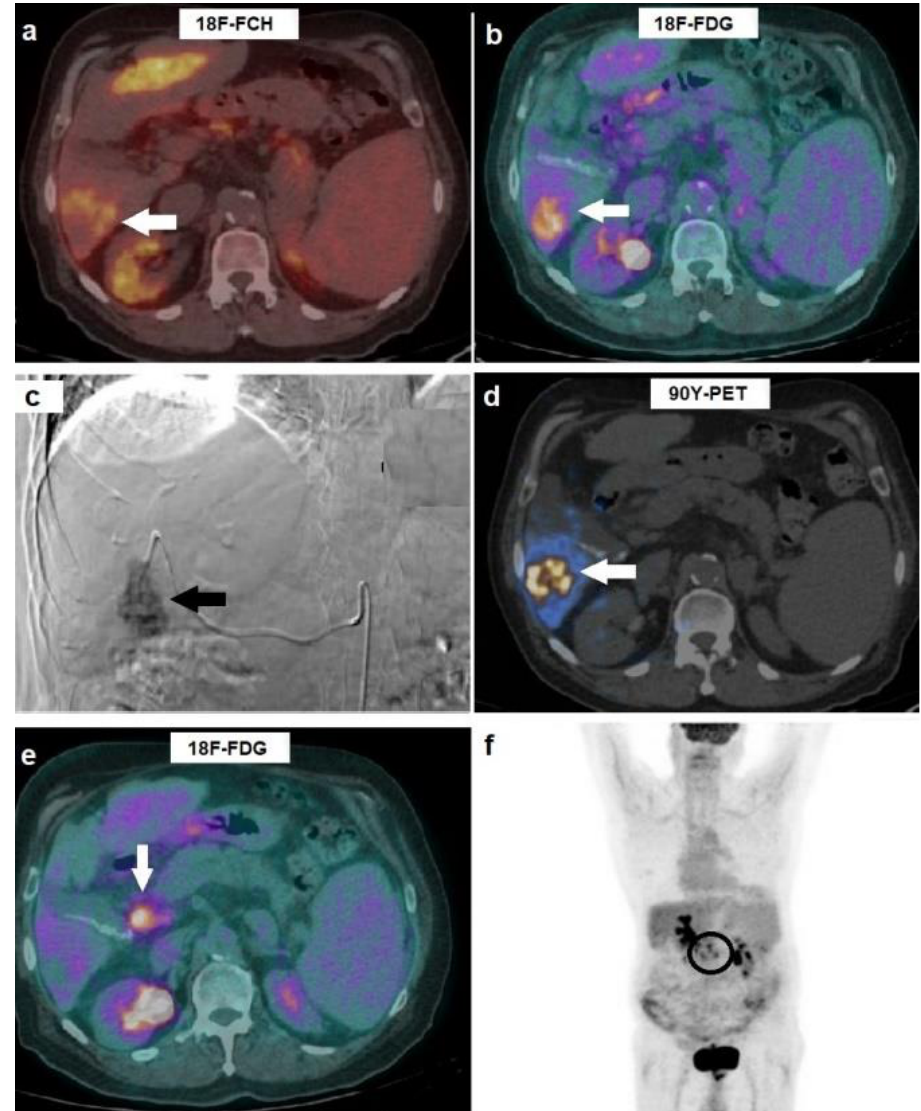
Figure 2. A 79-year-old man affected by HCV-related cirrhosis and HCC in the right hepatic lobe, previously treated with TACE and relapsed, referred to our center for 90 Y-TARE. ( a ) Pre-treatment 18 F-FCH PET/CT resulted negative for tracer incorporation in the HCC lesion located in the sixth hepatic segment (arrow). ( b ) Subsequently performed 18 F-FDG PET/CT showed highly increased uptake (SUVmax 7.6) in HCC (arrow). ( c ) Pre-TARE angiogram, acquired after selective catheterization of the arterial branch for the sixth segment, clearly showed the hypervascularized lesion (arrow). ( d ) 90 Y-PET, performed 4 h after 90 Y-TARE, depicted selective microsphere accumulation in treated tumor (arrow). ( e ) On the 8-weeks post-treatment PET/CT scan, new-onset hypermetabolic pathological celiac adenopathies (arrow), in spite of complete regression of the treated HCC, were evident. ( f ) Maximum intensity projection 18 F-FDG PET demonstrated well the metastatic localizations to abdominal nodes (circle).